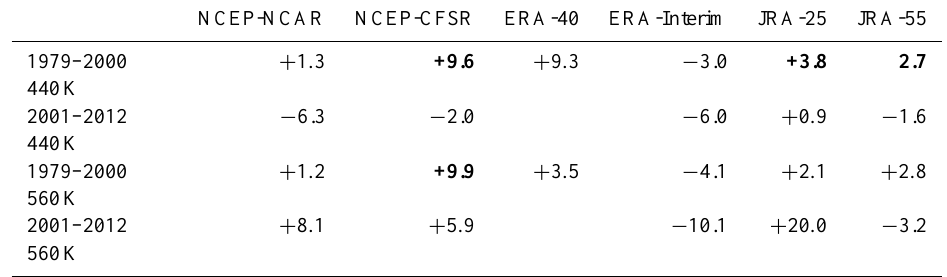
Table 5. Linear trend of the annual mean tropical total mean upward flux (in %decade − 1 ) during the first 22 years (1979–2000), and during the last 12 years (2001–2012) at 440 and 560K. The linear trend with a confidence level greater than 95% is shown in bold.